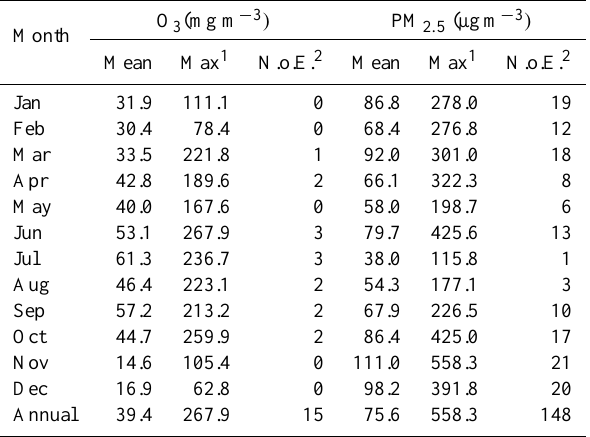
Table 2. Monthly statistics of average, maximum and number of exceedances of O 3 and PM 2 . 5 compared with the National Ambient Air Quality Standards in